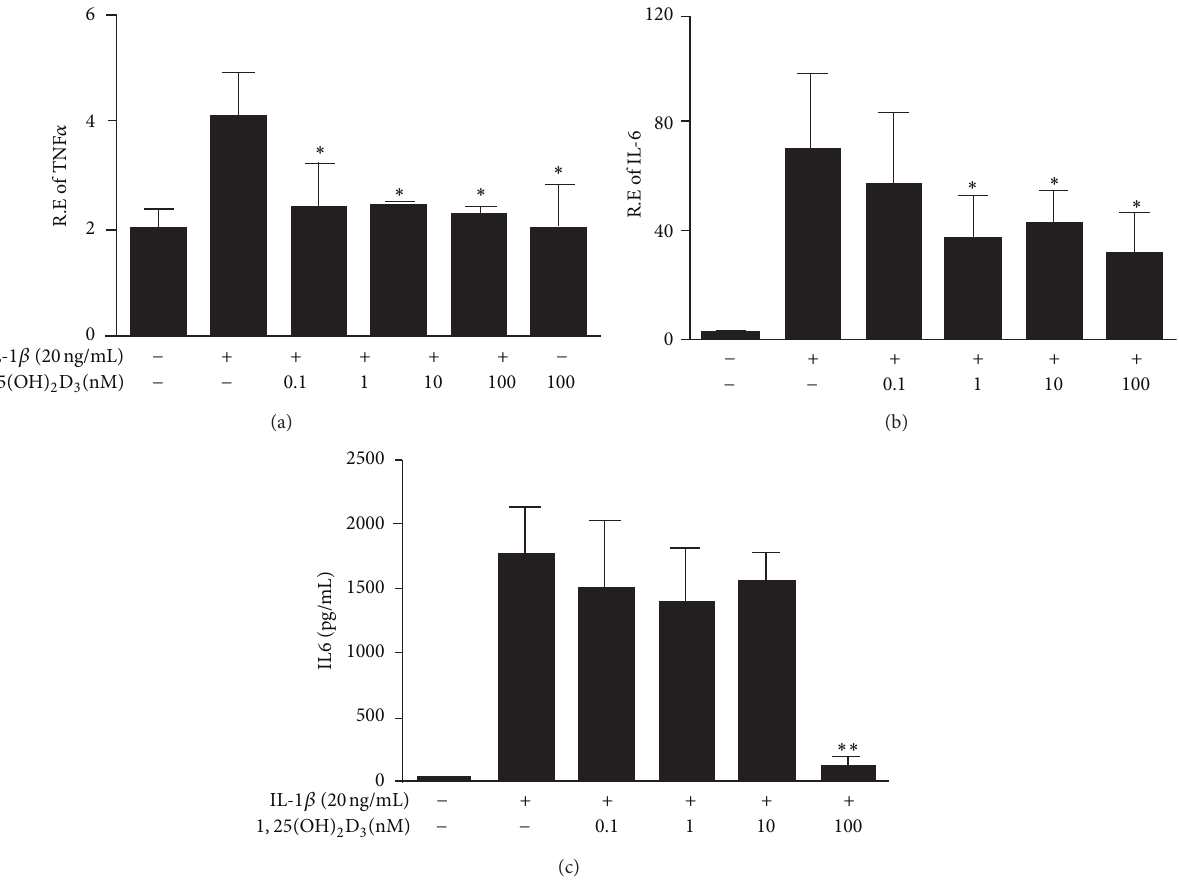
Figure 4: Effect of 1,25(OH) 2 D 3 on IL 𝛽 -induced TNF 𝛼 and IL-6 production in MH7A. MH7A cells were stimulated with 20ng/mL IL1 𝛽 and then treated with different concentrations of 1,25(OH) 2 D 3 (0.1nM, 1nM, 10nM, and 100nM) for 48h. The effects of 1,25(OH) 2 D 3 on IL 𝛽 -induced TNF 𝛼 (a) and IL-6 (b) mRNA expression in MH7A was analyzed by real-time PCR, and the production of IL-6 in supernatants was shown in (c). The data shown are the mean ± SD for three independent experiments, each in triplicate. ∗ 𝑃 < 0.05 compared to cells cultured with IL-1 𝛽 alone. ∗∗ 𝑃 < 0.01 compared to cells cultured with IL-1 𝛽 alone.